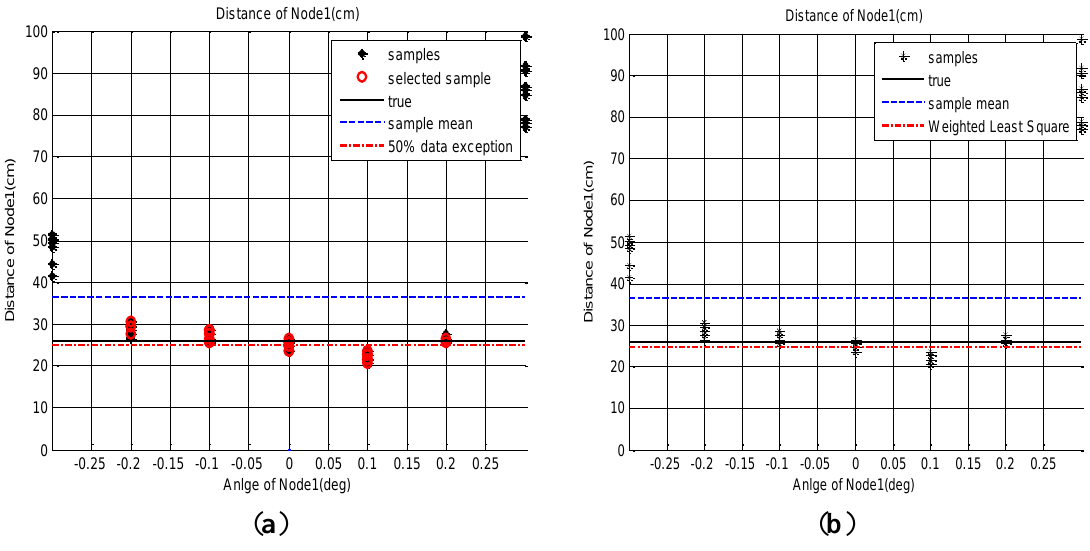
Figure 16. Position error of the repeated tests with the error reduction methods. ( a ) 50% data exclusion method, ( b ) RLS method.